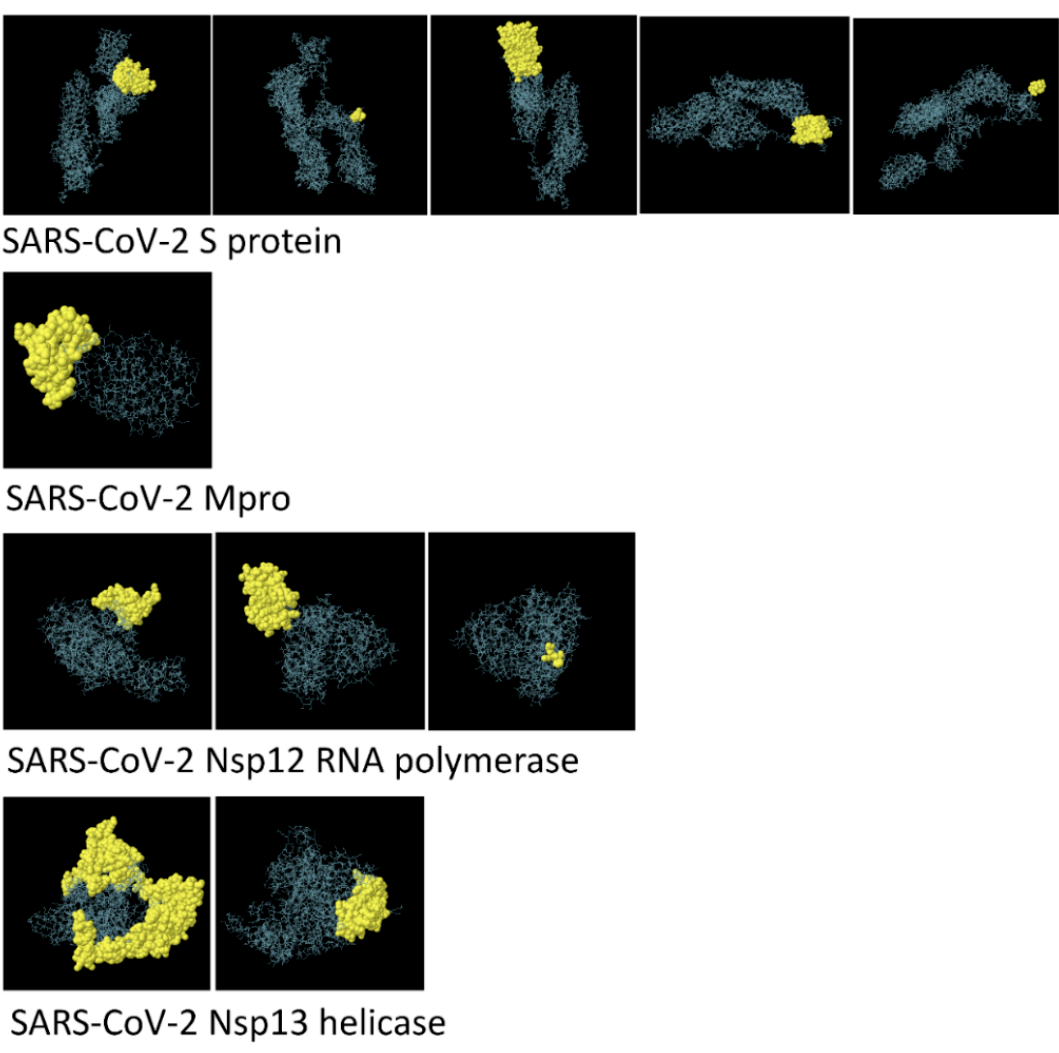
Figure 1. 3D representation of discontinuous epitopes of severe acute respiratory syndrome coronavirus 2 (SARS-CoV-2) spike, Mpro, Nsp12 RNA polymerase, and Nsp13